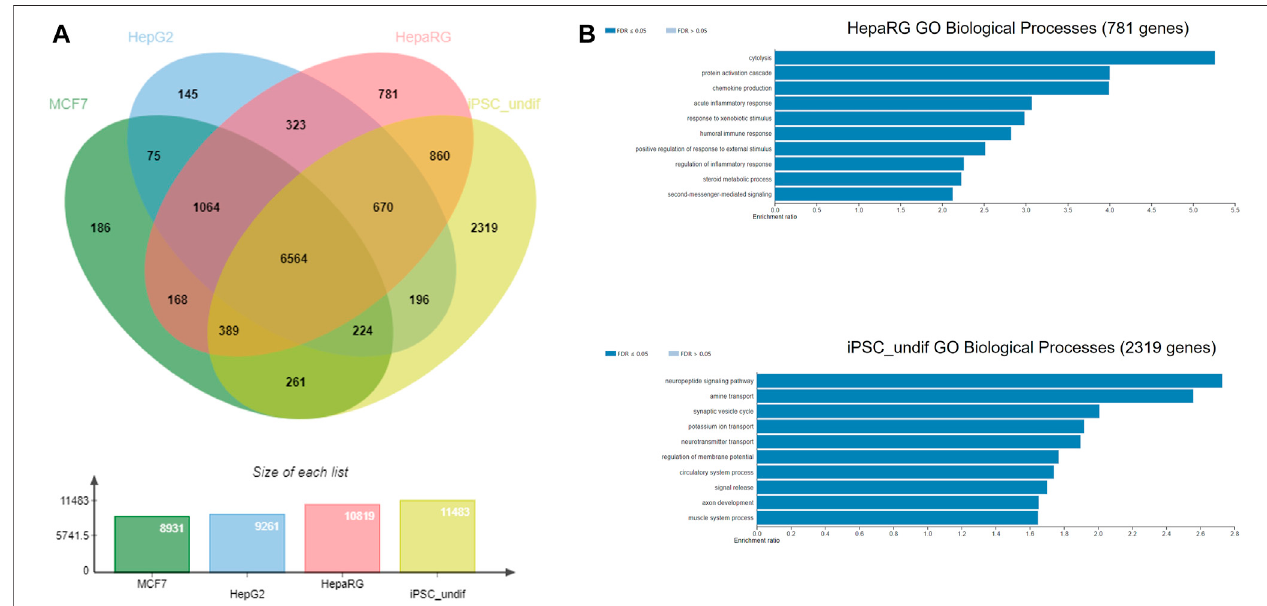
FIGURE 7 | (A) Gene coverage across MCF-7, HepG2, HepaRG and undifferentiated iPSC cell lines (B) Over-represented processes exclusive for HepaRG and iPSC cells, analysed using WebGestalt.